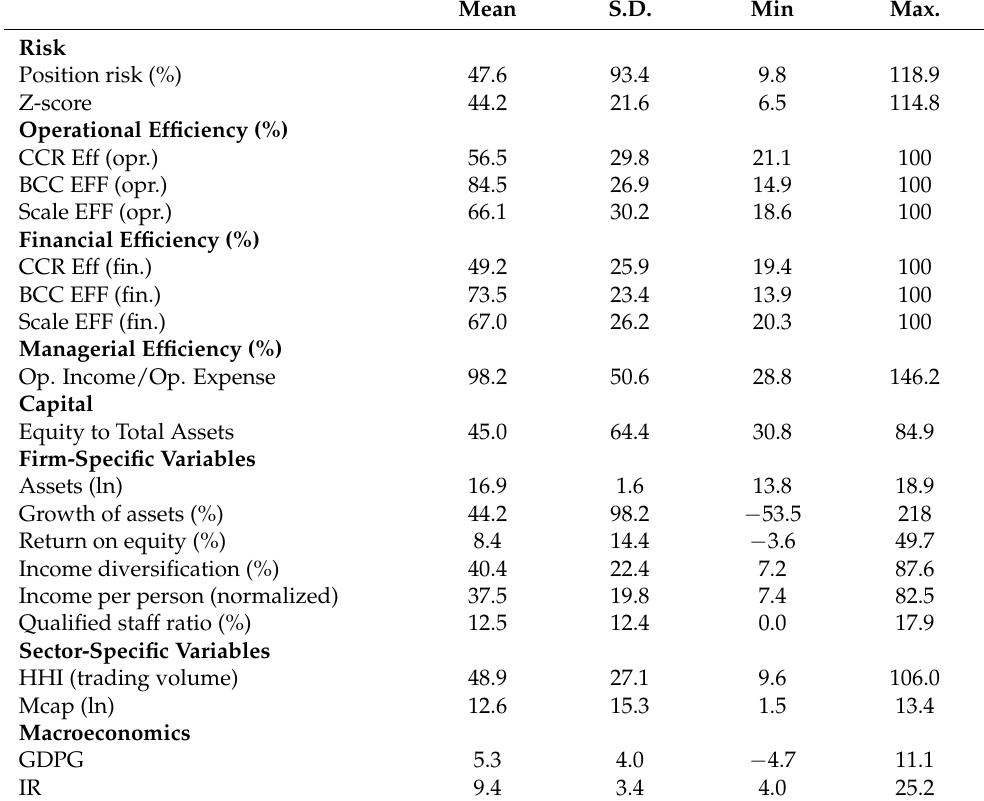
Table 6. Summary of Statistics of Variables (2004 Q1–2021